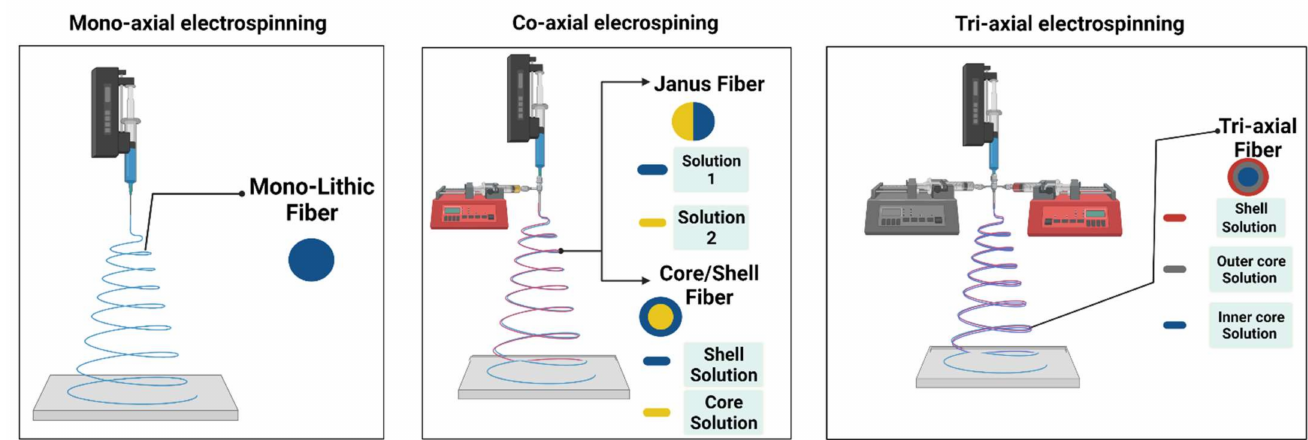
Figure 1. Techniques for nanofiber